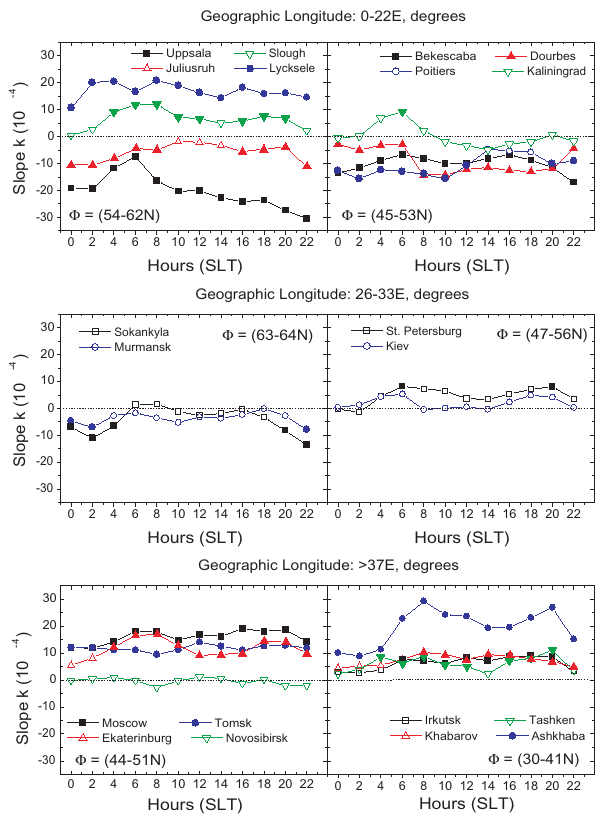
Fig. 5. Diurnal variation of the hm F2 trends in three longitudinal sectors. Regression of hm F2 with R 12 + Ap 12 (Model 2) was used. Filled in symbols correspond to significant trends at a 95% confi- dence level. The interval of geomagnetic latitudes 8 where stations are located is given in the